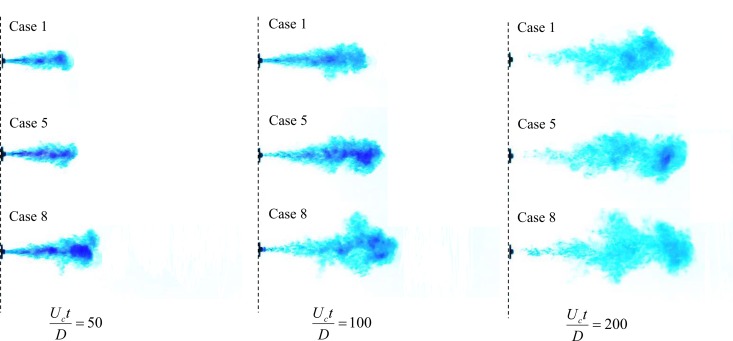
Visualizations of the turbulent round starting and interrupted jets.Case 1 [pulsation], Case 5 [sinusoidal] and Case 8 [real-cough]. Rec = 5200 and Q/AD = 100 for all cases. The flow transition from the starting to the interrupted jet stage occurred at Uct/D = 100 when the source supply is terminated.